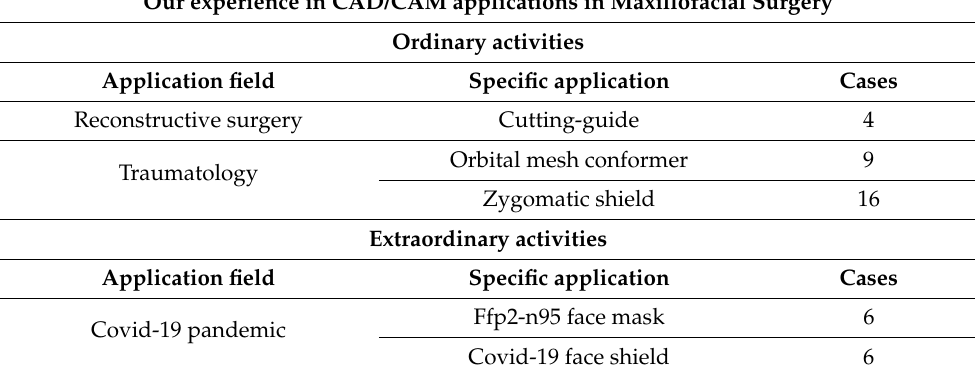
Table 1. Our cases ordered according to